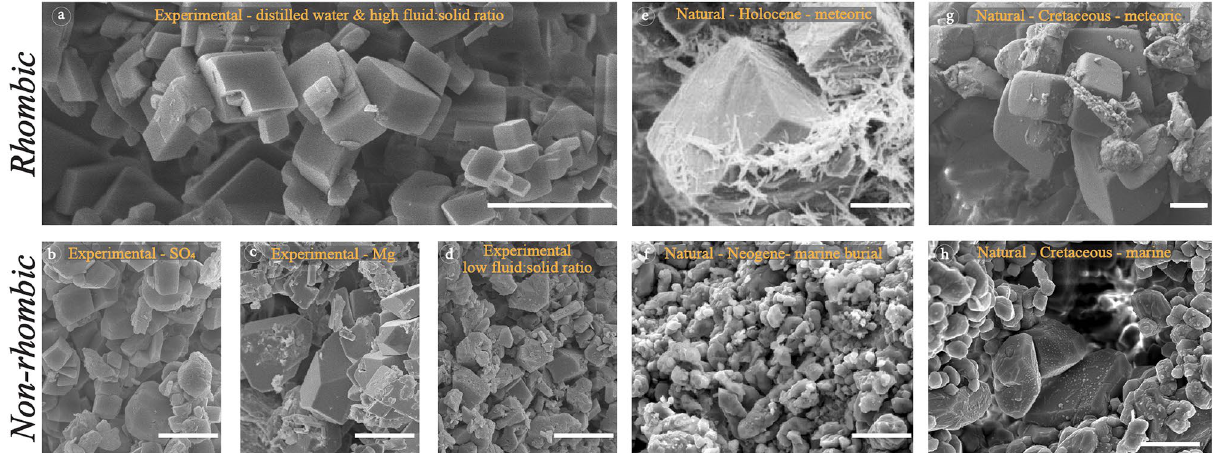
Figure 1. SEM images showing calcite microcrystals from various experimental and natural samples. ( a ) Rhombic microcrystals from aragonite to calcite stabilization experiments in distilled water and high fluid to solid ratio. ( b ) Polyhedral (multi-faceted) microcrystals from stabilization experiments in the presence of SO 4 2− ([Na 2 SO 4 ] = 28 mM). ( c ) Polyhedral microcrystals from stabilization experiments in the presence of Mg 2+ ([MgCl 2 ] = 5 mM). ( d ) Polyhedral and anhedral microcrystals from stabilization experiments at low fluid to solid ratio (0.3 mL/g) ( d is modified after Ref. 16 ). ( e ) Rhombic calcite microcrystals among aragonitic needles in Holocene sediments from the Bahamas, interpreted to have crystallized from freshwater (modified after Ref. 21 ). ( f ) Polyhedral and anhedral calcite microcrystals from Clino well (1769 ft) drilled on the western edge of the Great Bahama Bank, interpreted to have crystallized from marine-derived pore fluids (modified after Ref. 25 ). ( g ) Rhombic calcite microcrystals from the Lower Cretaceous Stuart City Trend interpreted to have formed during meteoric diagenesis. ( h ) Polyhedral calcite microcrystals from a carbonate reservoir in the Middle East interpreted to have formed during marine burial diagenesis. All scale bars are 5 µm.